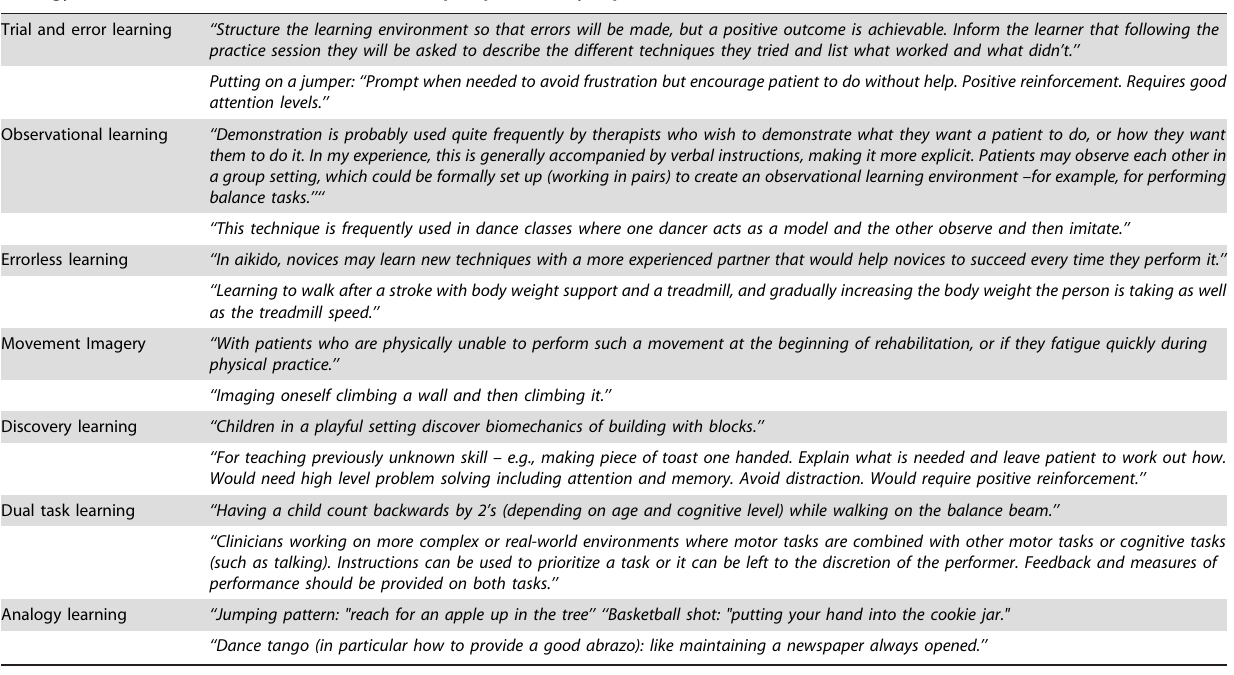
Strategy Two random selected examples provided by experts Trial and error